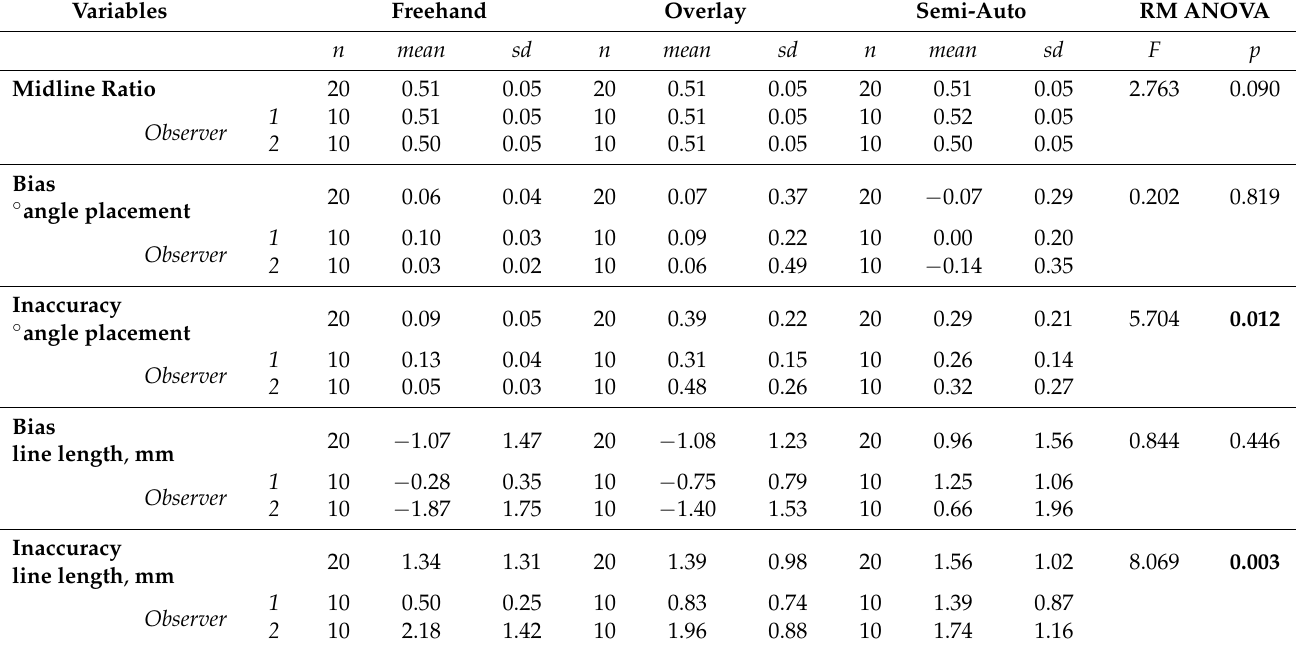
Table 3. Interobserver error summary statistics and the results of two-way (round*mode) repeated measures analysis of variance (RM ANOVA) across the three modes using transformed